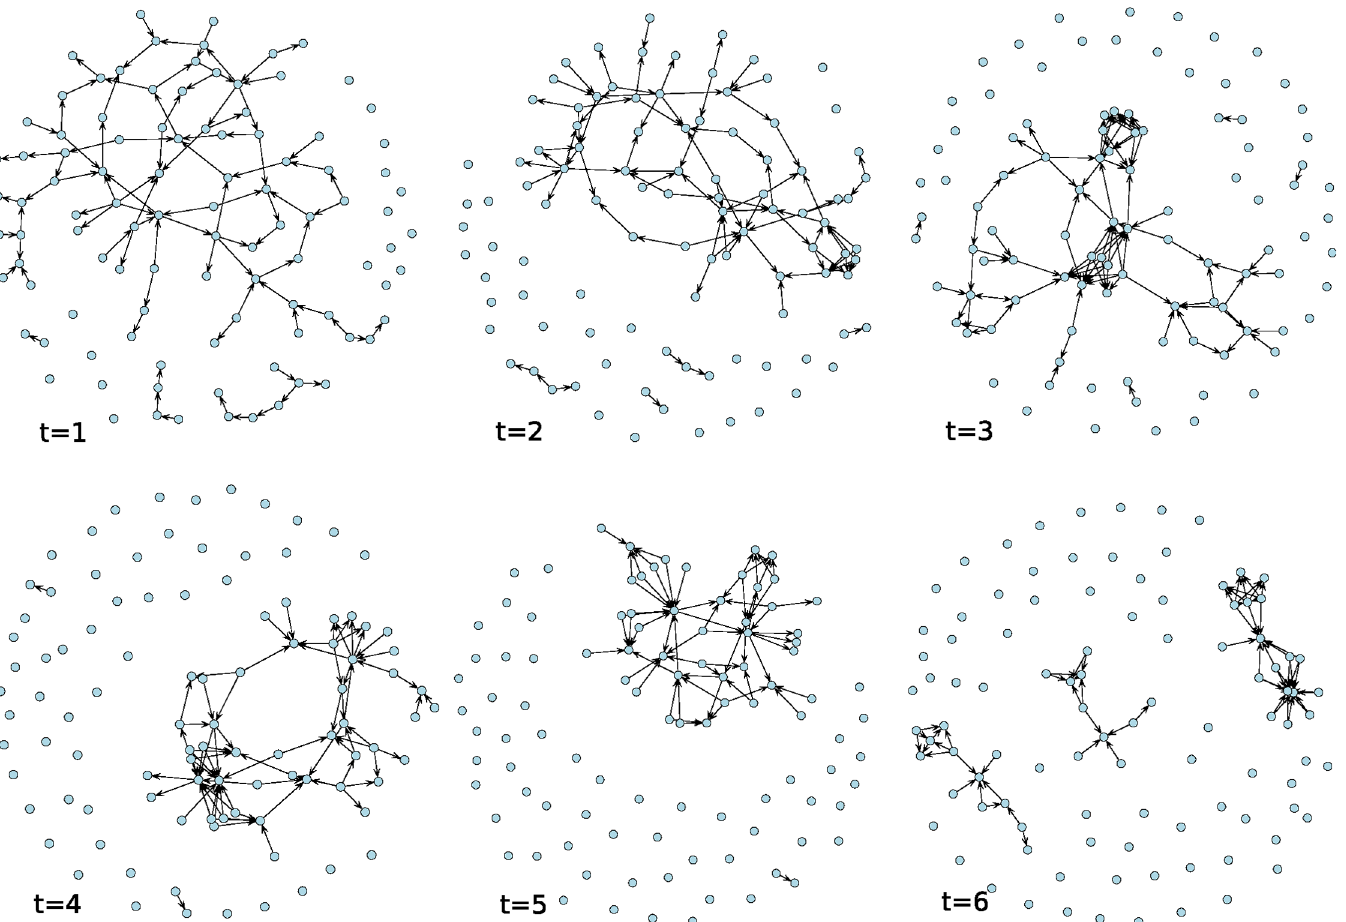
Fig 3. Evolution of social influence on a random graph with n = 100 nodes and graph asymmetry of 0.02. Patterns of influence among individuals (nodes) over time represented as networks in which a tie denotes the presence and direction of social influence between two individuals at a particular time.